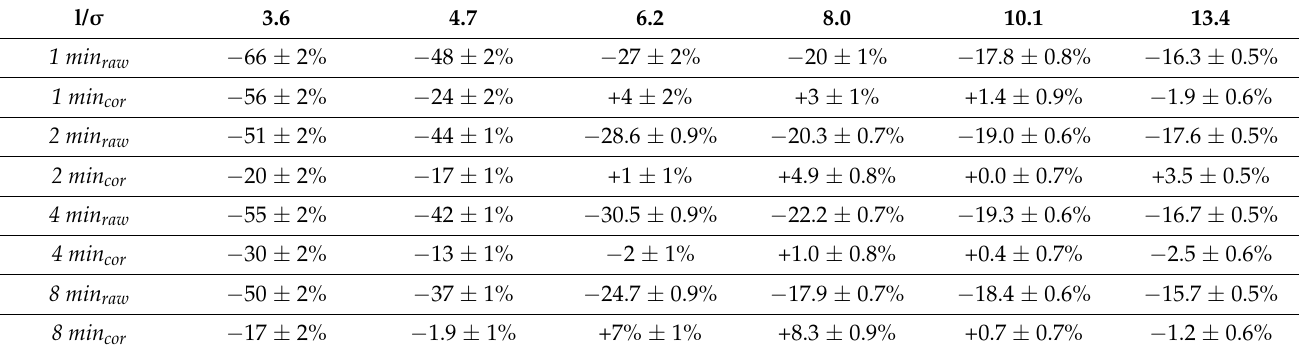
Table 5. Comparison of percentage of recovery at different acquisition time for the six spheres of NEMA phantom, where the dimensions are expressed as the ratio between the diameter of the six spheres and the PSF of the system.